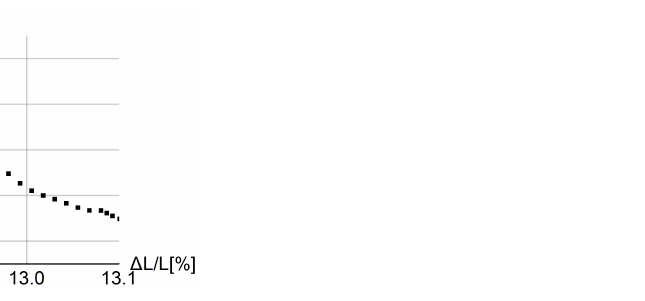
Figure 8. Stress vs. relative extension for one serration with step numeration ( ξ = 40 MPa · s, k = 121 J/(s · K · m) and t 0 = 0.125 s).